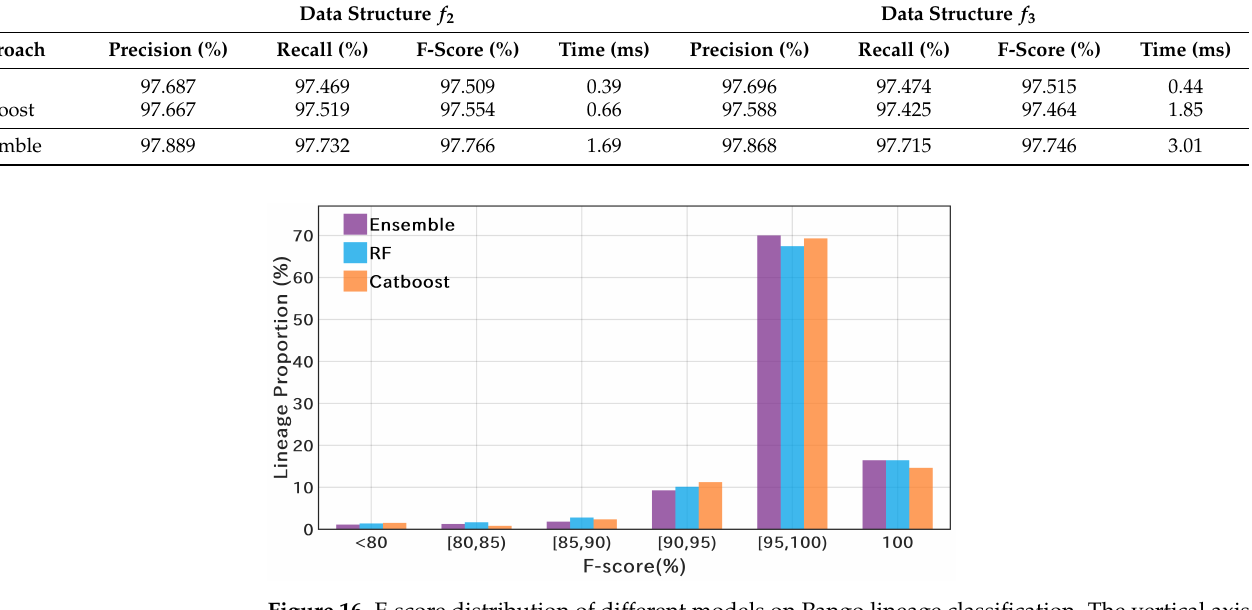
Table 5. Results of the Pango lineage classifiers on the testing dataset S P